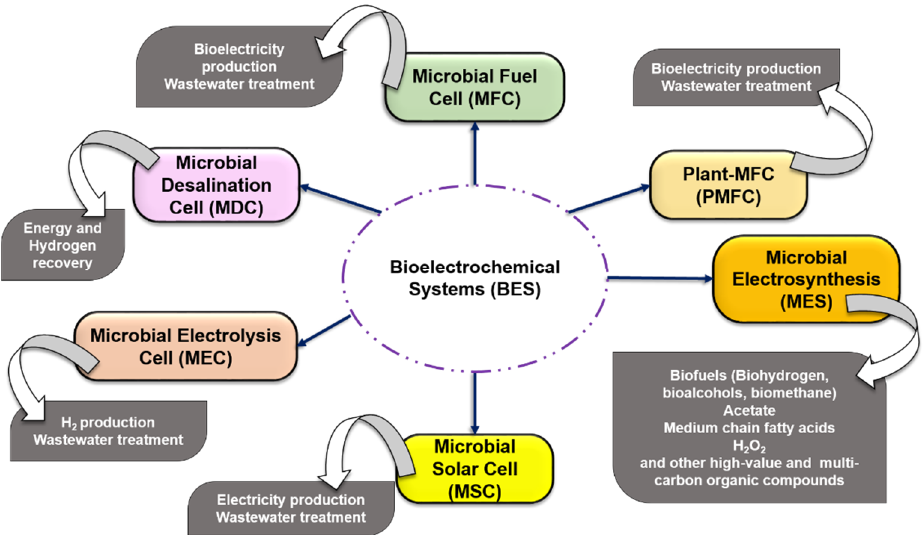
Figure 1. A schematic overview of multiple categories of BESs depending on the mode of their applications [28,29,31].